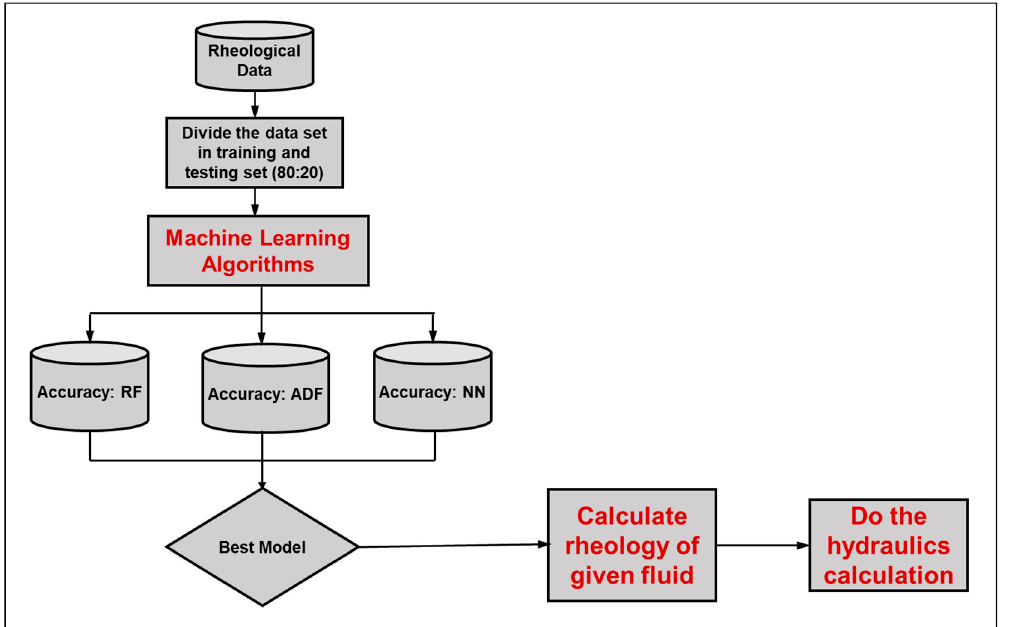
Figure 2. The workflow of this study.